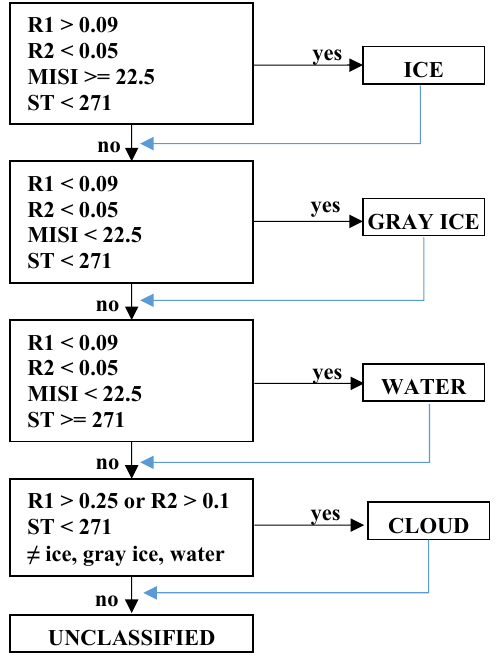
Figure 9. GOES snow/ice detection algorithm.